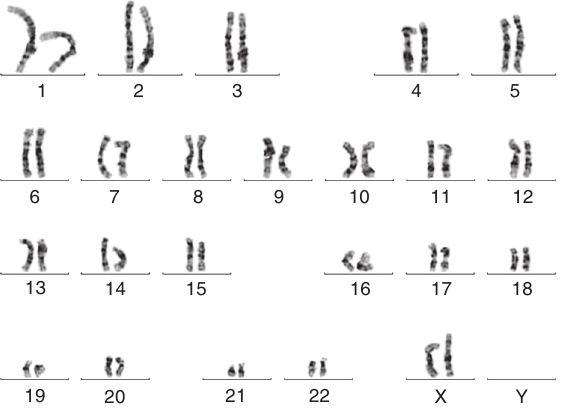
body (EB) formation: A, aver- age size of EBs; B, micro- graph of EBs formed from hu- man embryonic stem (hES) cells before spinner propaga- tion; C, micrograph of EBs formed from hES cells after spinner propagation (scale bar: 200 μ m for panels B and C). D-I, Immunocytochemistry for AFP (endoderm), α -SMA (mesoderm) and nestin (ecto- derm) in EBs formed after 7 days in traditional static cul- ture on inactivated mouse em- bryonic fibroblasts (MEFs) and after growth in spinner and then re-plating onto inac- tivated MEFs (scale bar: 100 μ m for panels D-I). J, FACS results of EB samples for markers of the three germ lay- ers: AFP (endoderm), α -SMA (mesoderm) and nestin (ecto- derm), before (red line) and after (green line) cell growth in the spinner system. AFP = alphafetoprotein; α -SMA = α - smooth muscle actin.